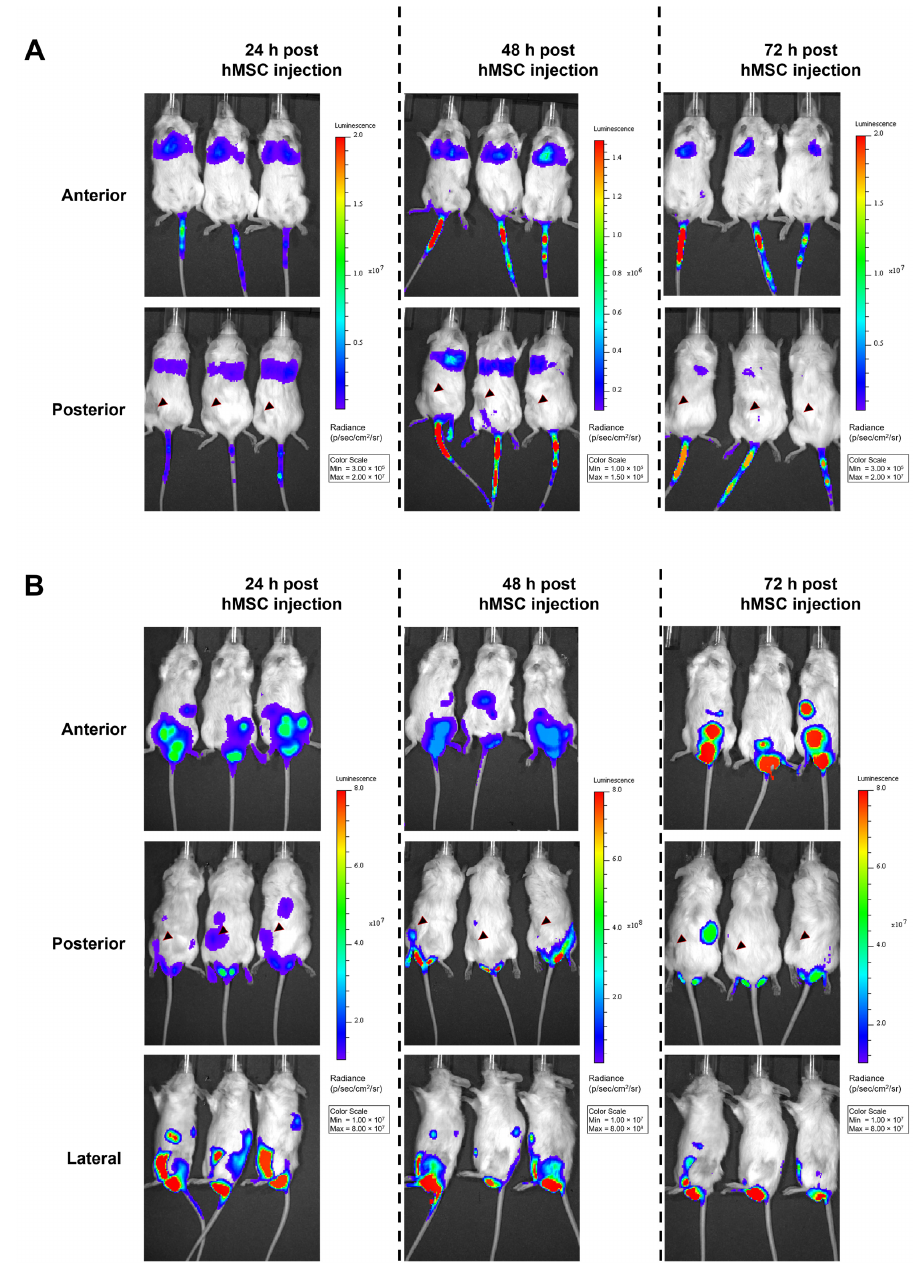
Figure 6. No migration of transduced hMSCs toward HNSCC xenograft tumors upon i.v. or i.p. injection in vivo. A total of 1 × 10 6 BM-hMSCs (transduced 3 h before with a firefly luciferase- encoding replication-deficient HAdV-5 vector + hFX as transduction enhancer) were injected either ( A ) into the tail vein of tumor-bearing mice after 14 days of tumor growth or ( B ) i.p. after 21 days of tumor growth. Starting 24 h post-hMSC injection, luciferase signals were analyzed using the IVIS 200 in vivo imaging system. Five minutes before analysis, firefly luciferase substrate was injected into the mice i.p. Representative images from the IVIS 200 system are shown. The locations of xenograft tumors are indicated with a black arrowhead (posterior view). Representative images of UD-SCC-2 xenograft-bearing mice are shown. Similar results were obtained in UD-SCC-6 xenograft-bearing mice (data not shown). In total, transduced hMSC were injected i.v. into 18 mice (UD-SCC-2: n = 12 14 days post-tumor injection, n = 3 21 days post-tumor injection, UD-SCC-6: n = 3 21 days post-tumor injection) and i.p. (UD-SCC-2, n = 3 21 days post-tumor injection). Mock (non-transduced) hMSCs were injected into four mice as a